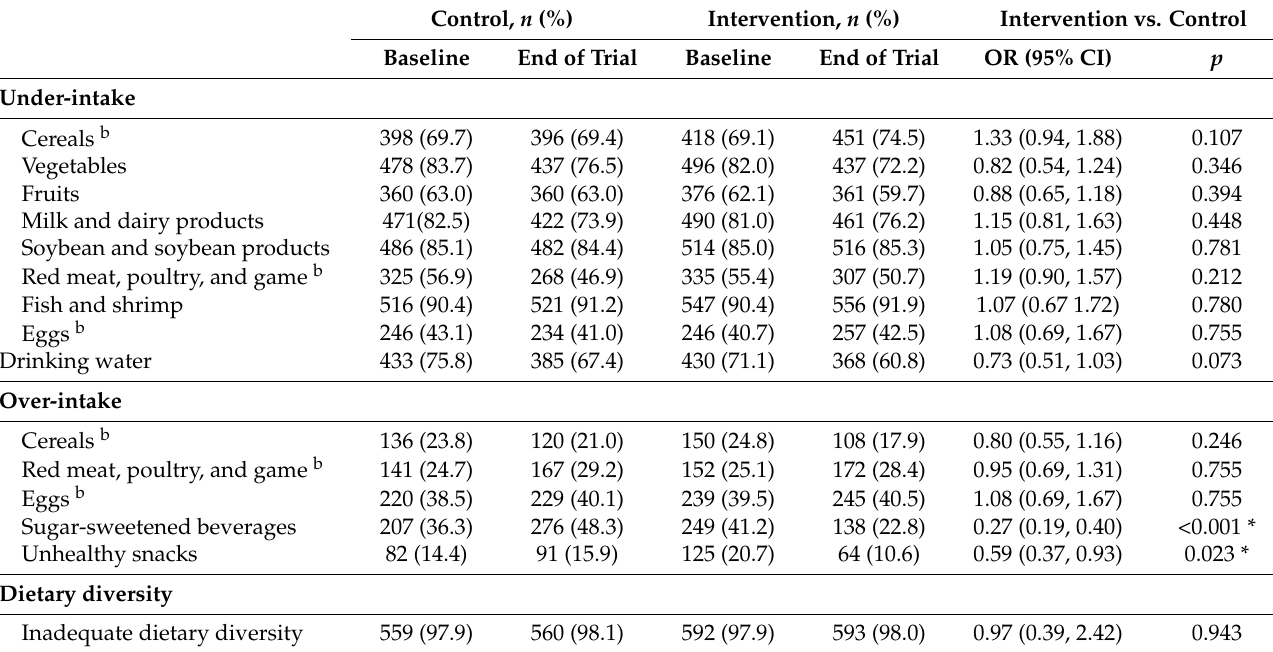
Table 2. Effects of intervention on the levels of each subgroup a